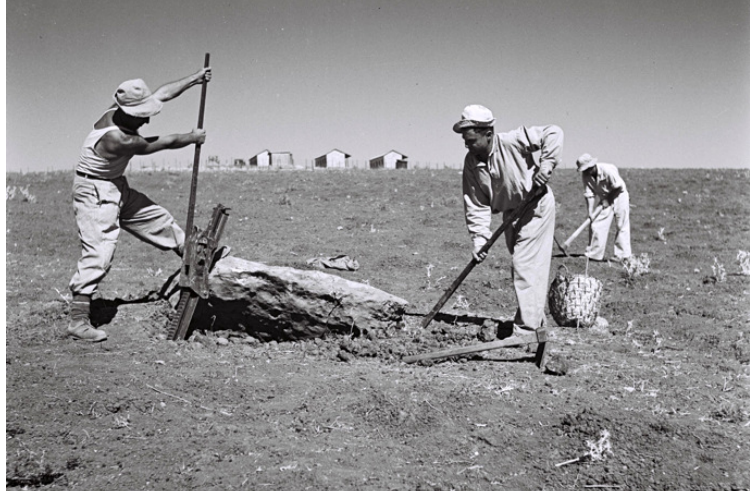
Figure 1. Workers in Kibbutz Gal‐On. Source: Kluger (1946).